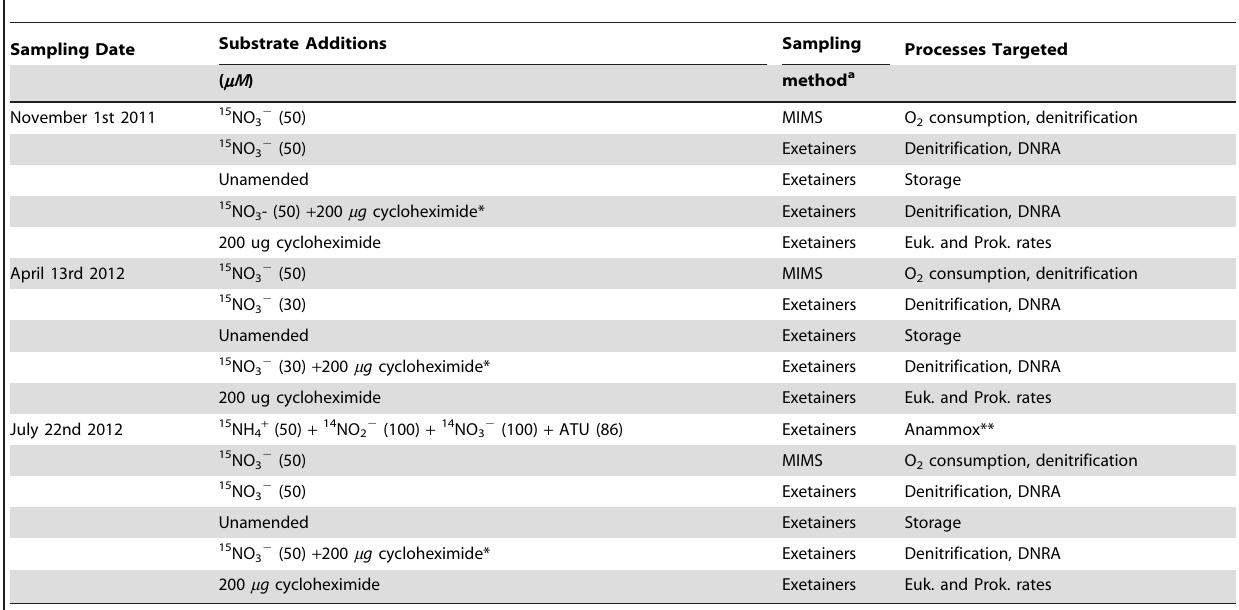
Table 1. Summary of sampling dates, conditions, and 15 N incubation experiments